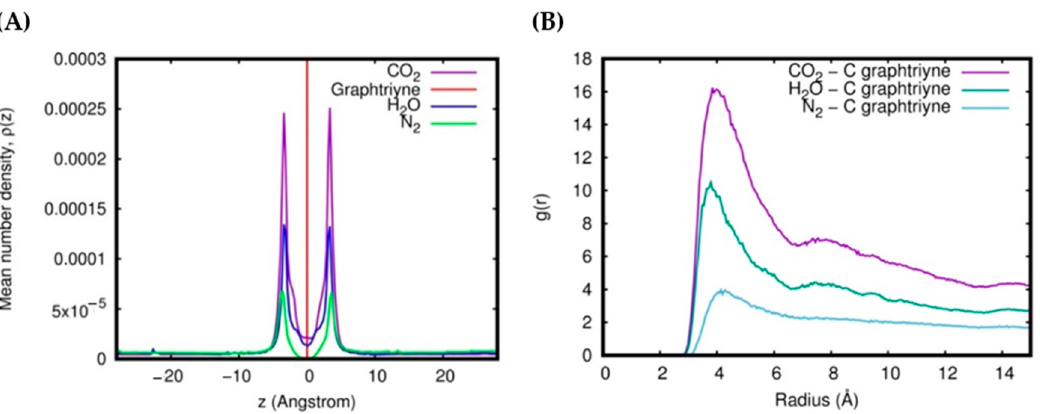
Figure 7. 𝑧 -Density profile ( A ) and radial distribution function ( B ) of the single-layer system at 1 atm and 353 K.